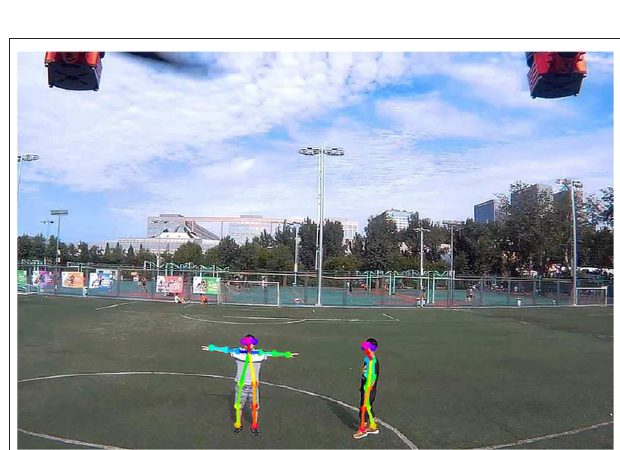
model uncertainties, a hovering experiment was conducted with BSC gains at M 1 and the STESO gains at ξ 1, i